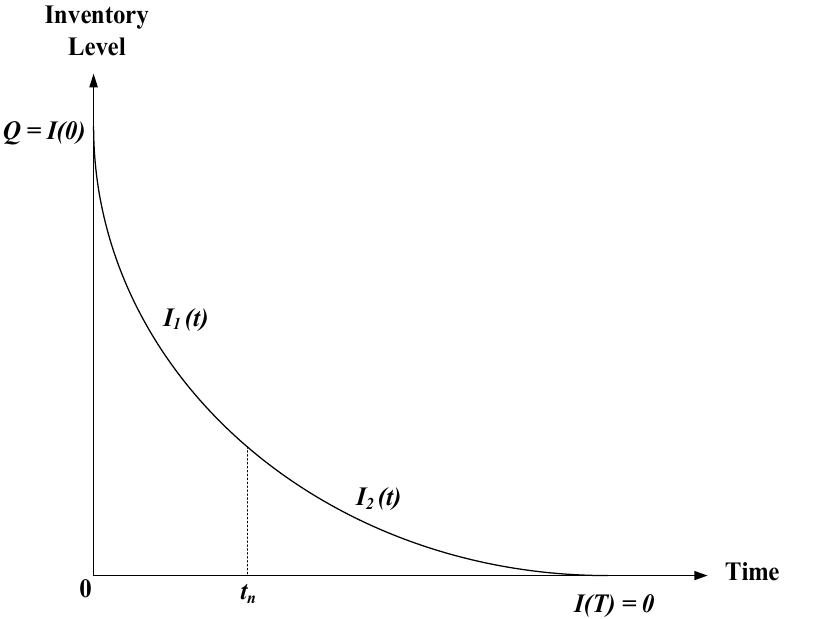
Figure 1. The inventory system and proposed problem (Adapted from [28]].